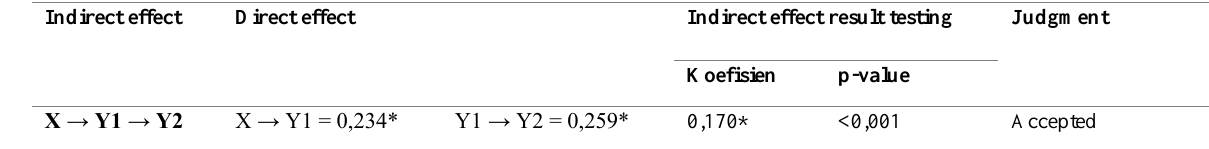
Table 4: Indirect testing of path